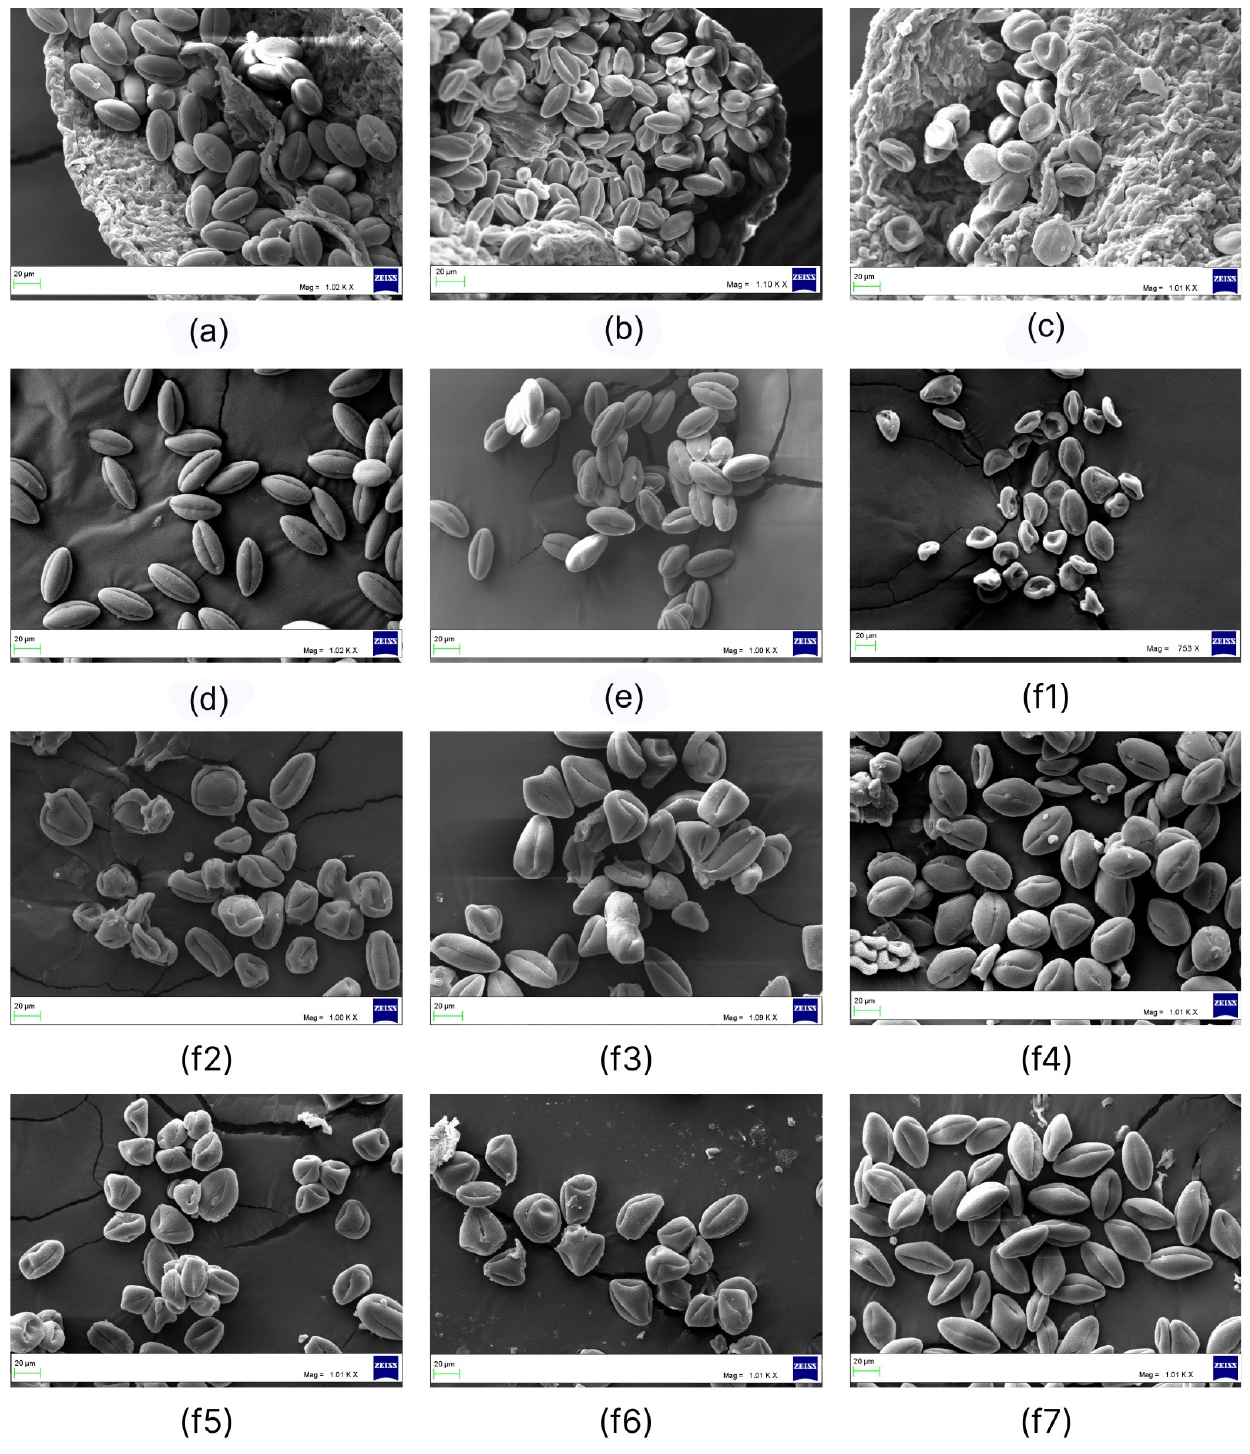
Figure 5. SEM micrographs of Nitraria pollen. ( a ) N. sibirica ; ( b ) N . komarovi ; ( c ) N . pamirica ; ( d ) N . tangutorum ; ( e ) N. praevisa ; ( f1 – f7 ) N . shoberi from ( f1 ) Balhash, ( f2 ) Kulunda, ( f3 ) Malinovoe, ( f4 ) Karatal, ( f5 ) Basshi, ( f6 ) Taskarasu, and ( f7 ) Sariozek.